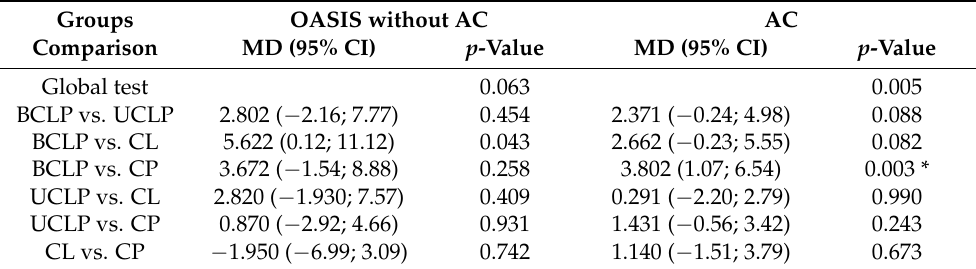
Table 5. OASIS/AC.